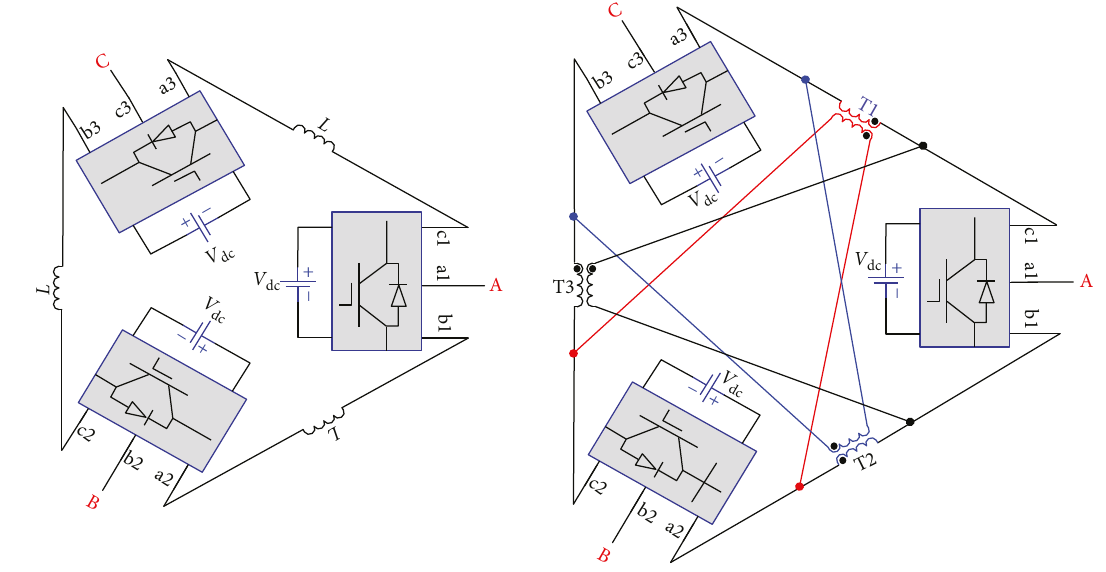
Figure 1: Topologies of cascade two-level